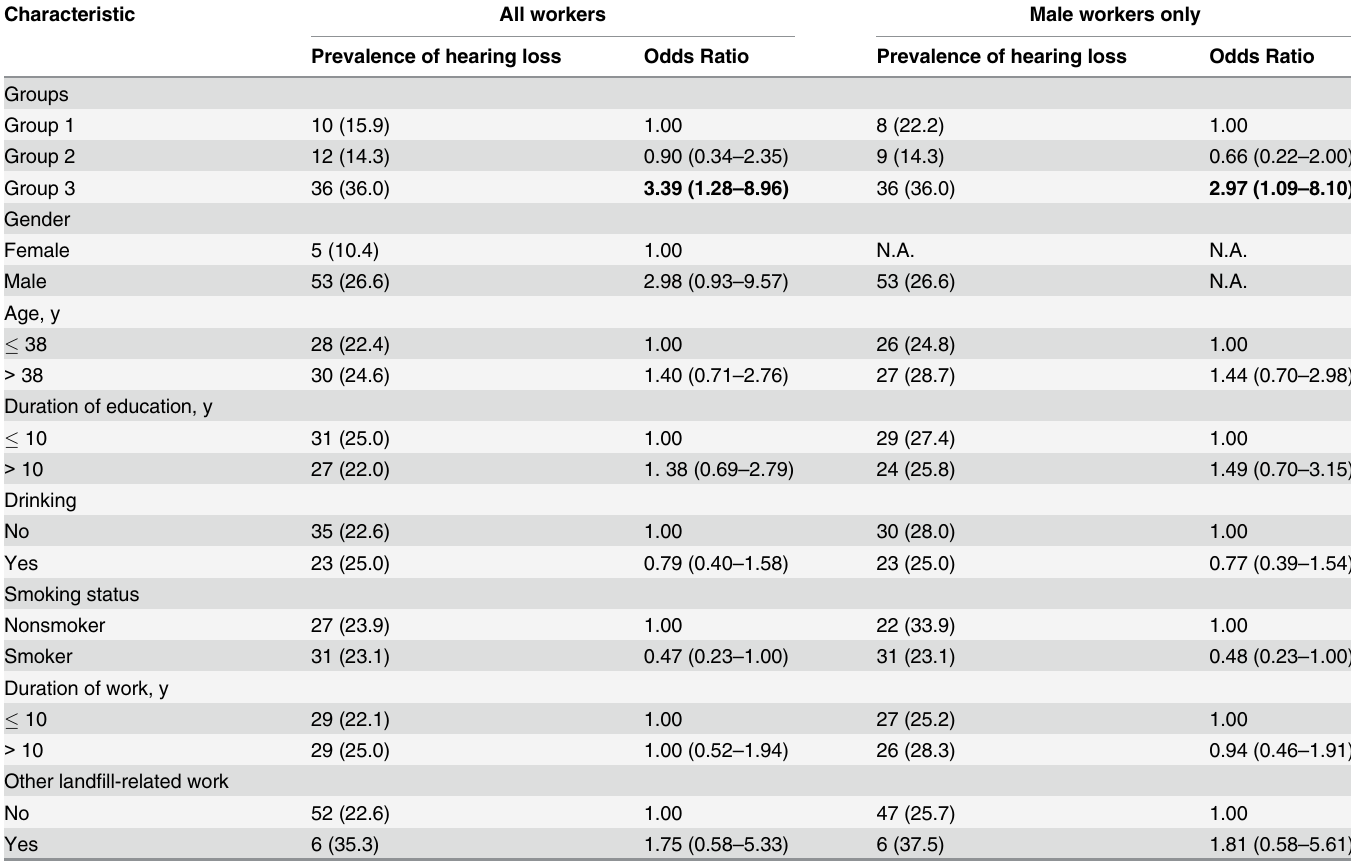
Table 6. Prevalence and odds ratios of hearing loss by selected characteristics in MSWL